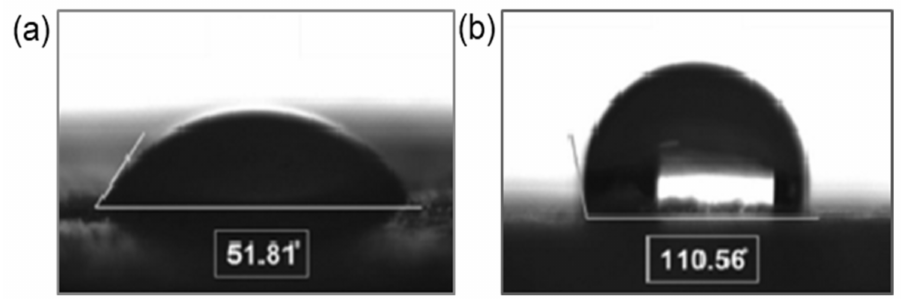
Figure 9. Contact angles of neat CNC ( a ) and CNC modified with isophorone diisocyanate ( b ) (repro- duced from [188] with permission of Elsevier).